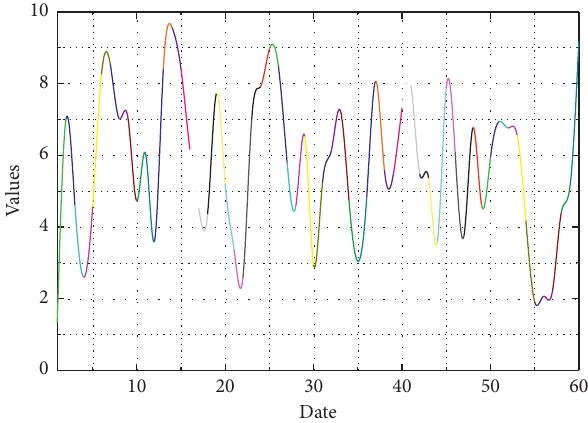
Figure 6: Time series plot of DAL stock